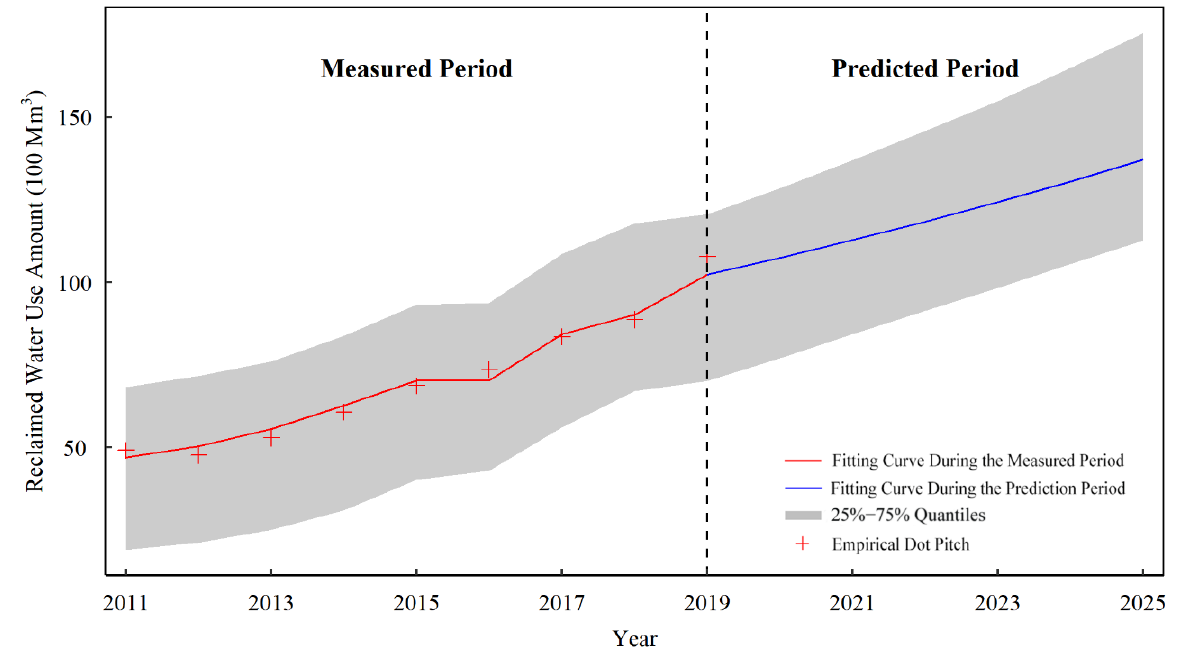
Figure 9. Potential reclaimed water availability.